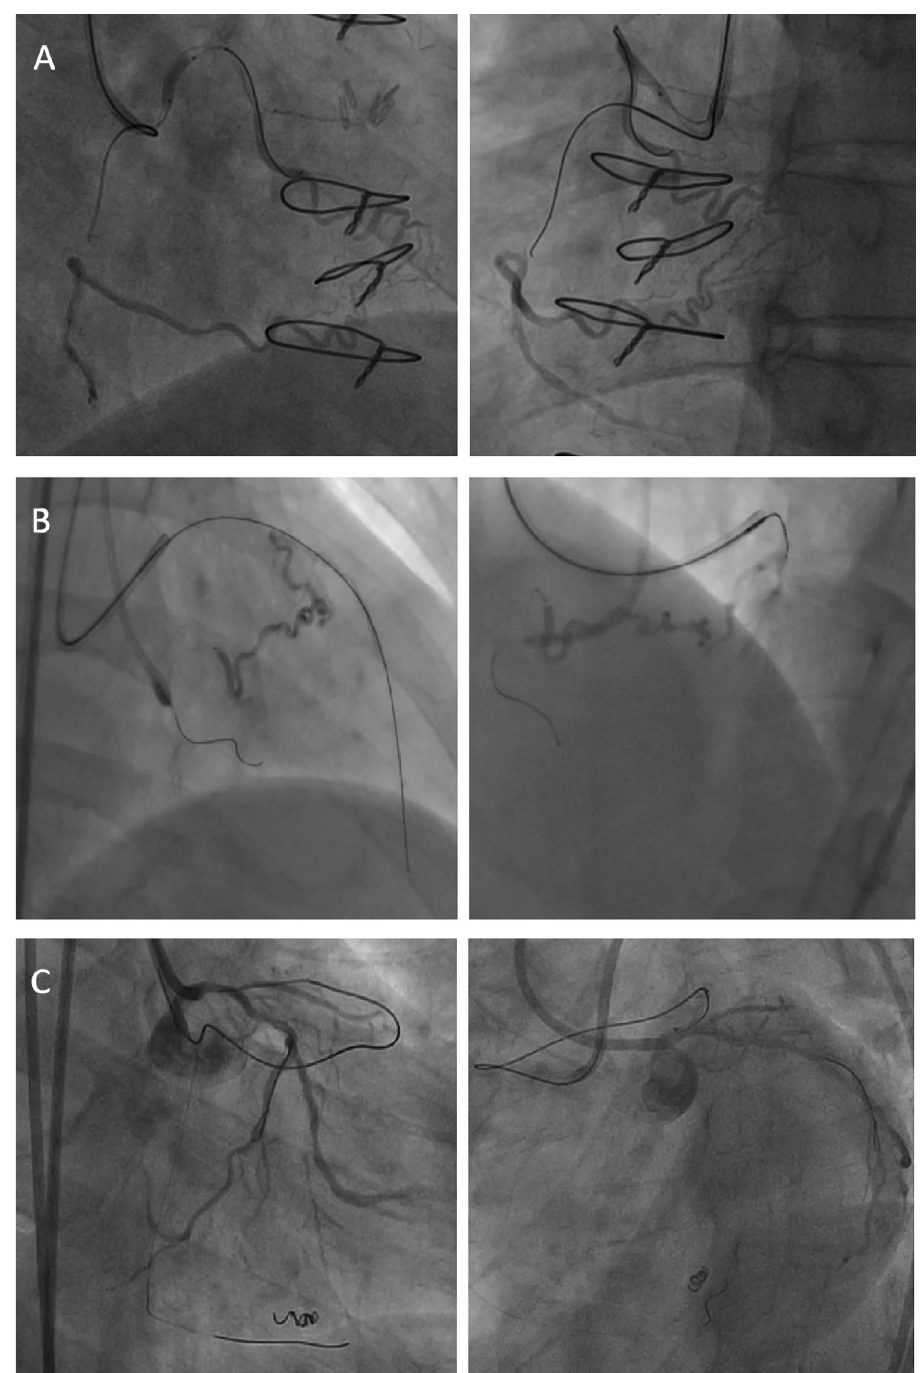
Figure 2. Utilization of conus branch. ( A ) balloon anchor to stabilize guiding catheter, ( B ) selective injection for antegrade wiring, ( C ) serve as retrograde collateral